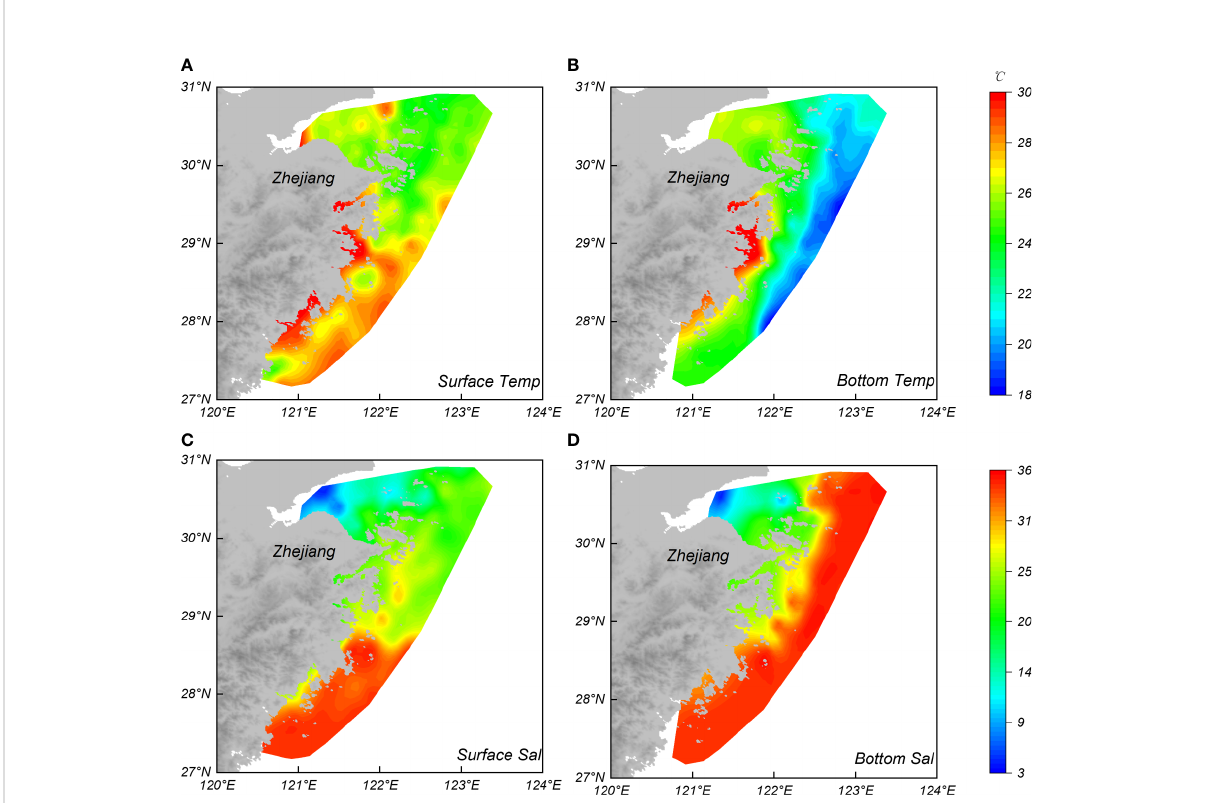
FIGURE 3 Horizontal distribution of temperature [surface (A) and bottom (B) ] and salinity [surface (C) and bottom (D) ] in the Zhejiang coastal area.